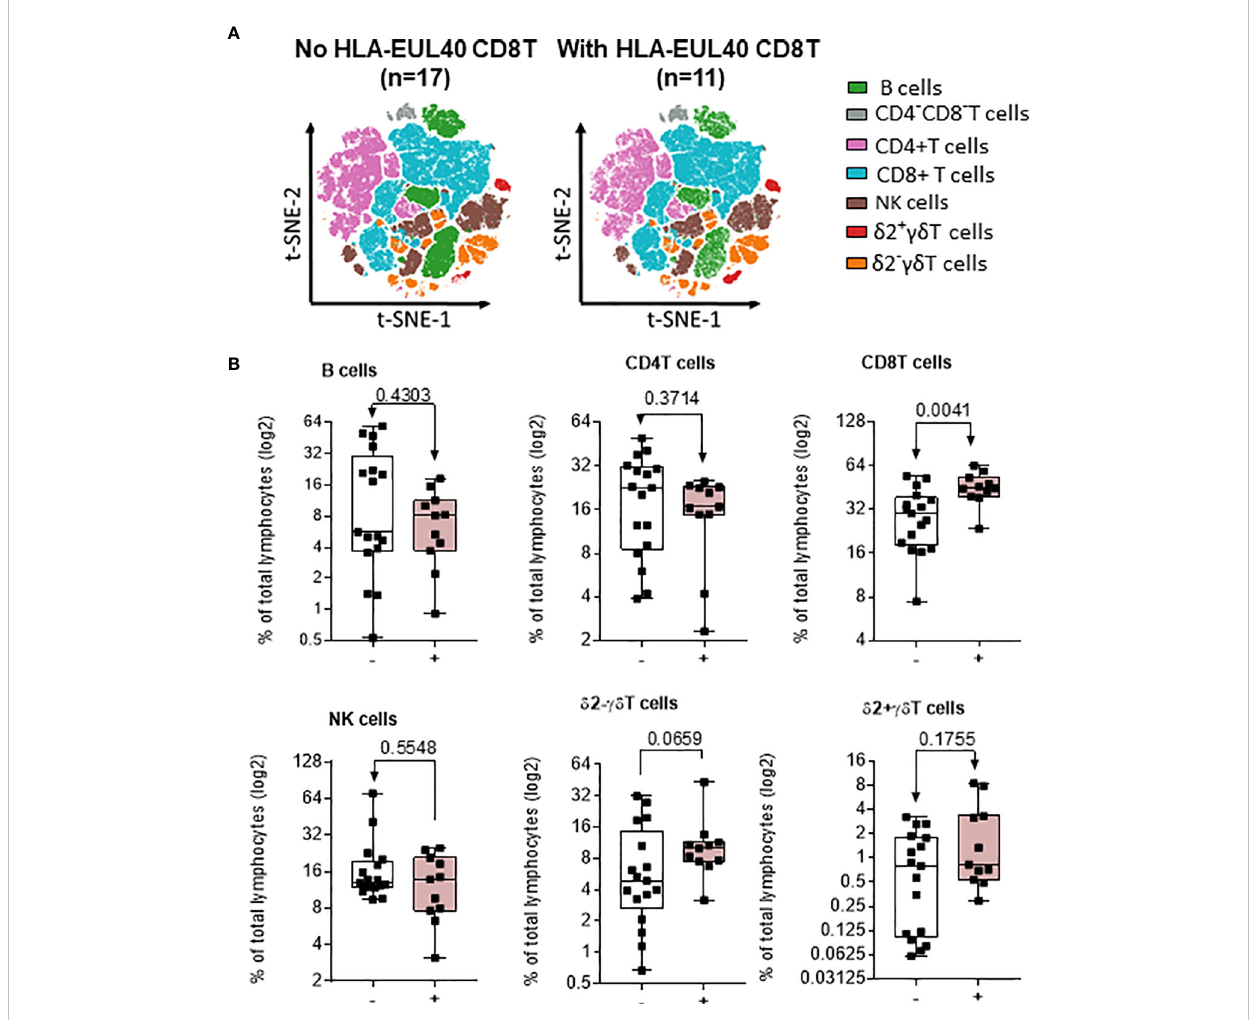
FIGURE 7 Impact of EUL40 CD8 T cells on the distribution of immune subsets post-infection in STABLE LTRs. (A) Visualization (opt-SNE) of the relative abundance of the seven main lymphocyte populations on samples with ( n = 11) or without ( n = 17) EUL40 CD8 T detected from STABLE LTRs harvested after HCMV infection. Lymphocyte populations including B, NK, CD4 − CD8 − T, CD4 + T, CD8 + ab T, d 2 − gd T, and d 2 + gd T cells were identi fi ed using manual assignation based on phenotype markers. (B) Frequencies (% total) of the seven main lymphocyte populations identi fi ed in samples harvested after HCMV infection from STABLE LTRs with or without EUL40 CD8 T detected. Results are shown in whisker plots with median and interquartile values, and each point corresponds to an individual sample. The groups were compared using the Mann – Whitney U test; p -values are